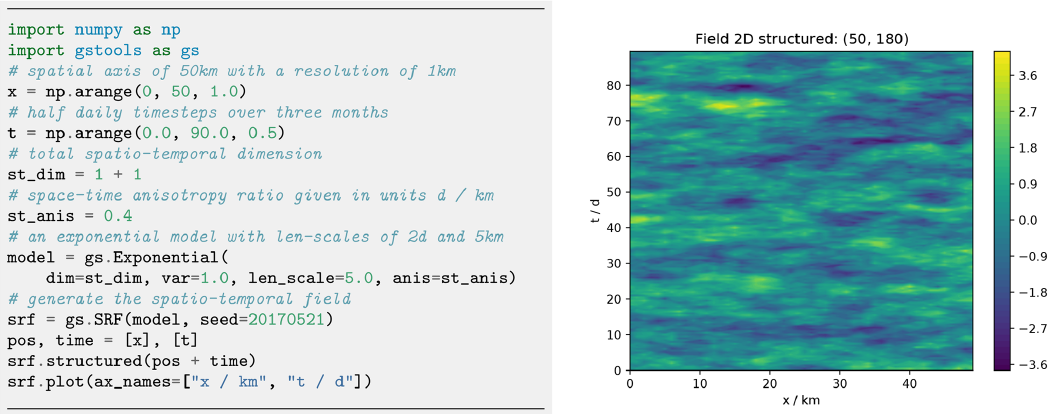
Figure 15. A workflow to generate a spatio-temporal random field with one spatial